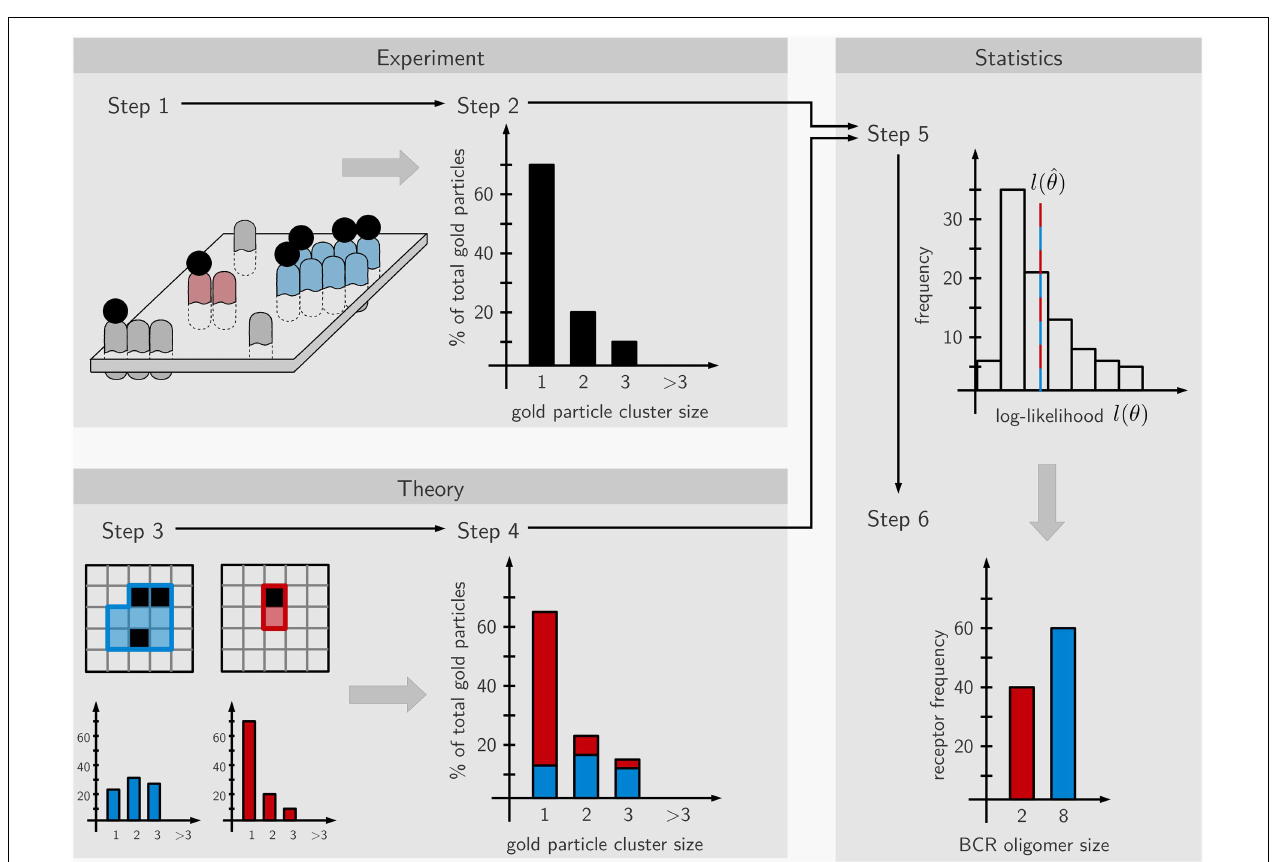
blue or red (each BCR occupies one square, thus showing a blue 8mer and a red dimer). In step 4, superposition parameters are estimated based on the observed gold particle distributions by maximum-likelihood estimation. In step 5 based on the estimated parameters, de novo , in silico cluster size distributions are repeatedly generated and the corresponding log-likelihood is re-optimized, providing a histogram of log-likelihood values. Step 6; if in accordance with the data, the theory makes a valid prediction for the underlying BCR nanocluster distribution and the relative amounts of the nanocluster sizes is